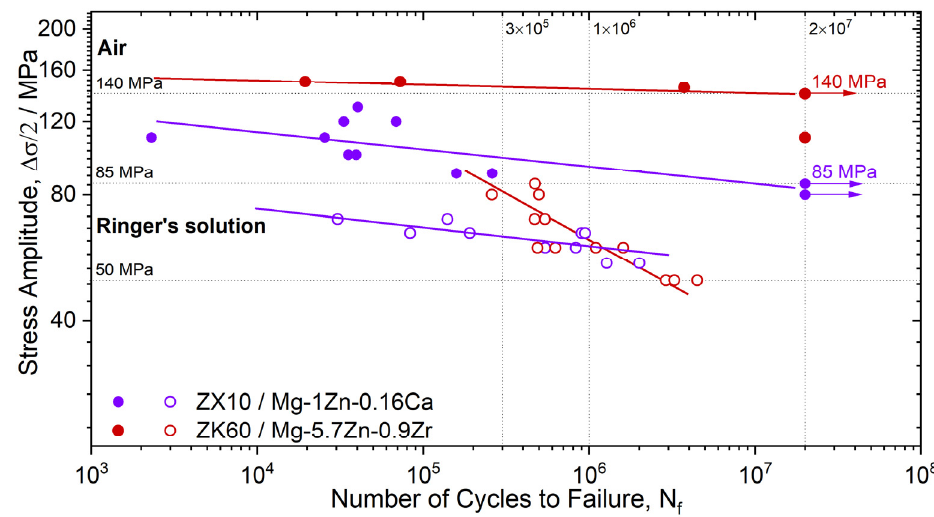
Figure 11. Wöhler plot for the Mg-1Zn-0.16Ca and ZK60 specimens tested at 80 Hz frequencies in air (filled circles) and Ringer’s solution (open circles). Arrows denote runouts. Table 6. Tensile, fatigue, and corrosion properties of magnesium alloys.